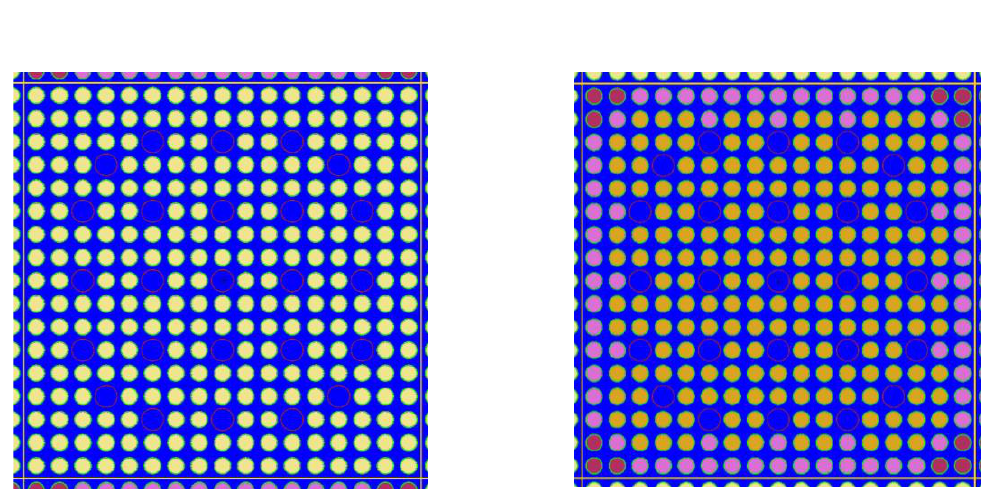
Figure 2. UOX assembly (Left); MOX assembly (Right) with 3 different types of fuel pins: high (orange), medium (rose) and low (red) Pu content.